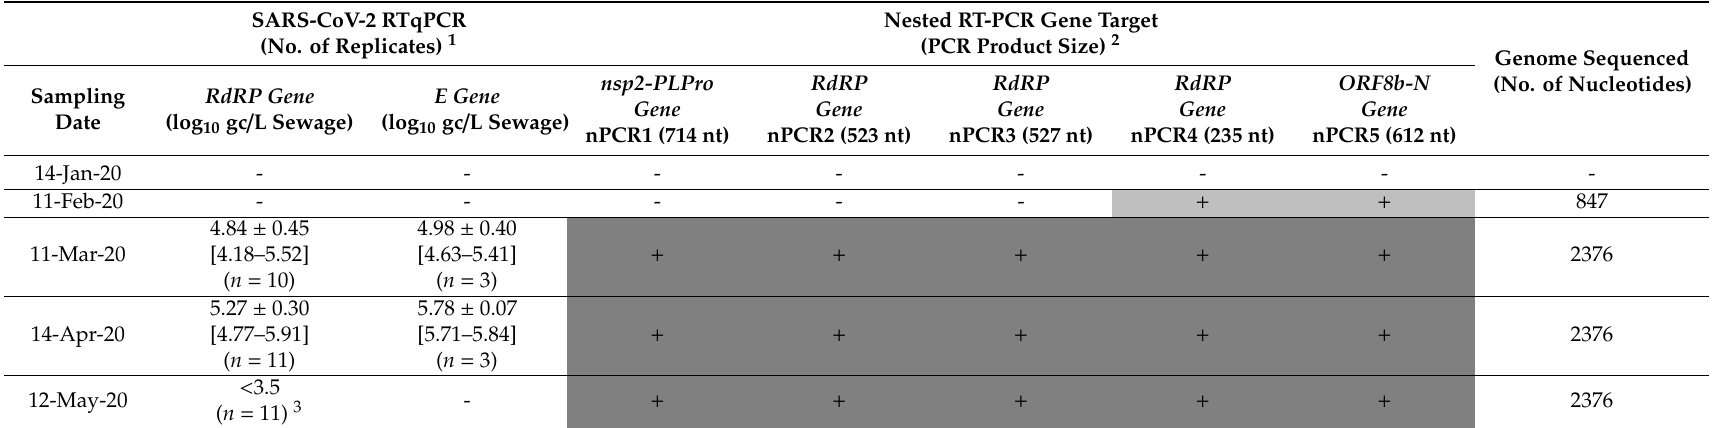
Table 1. Detection of Severe Acute Respiratory Syndrome Coronavirus 2 (SARS-CoV-2) viral RNA in wastewater concentrates by RTqPCR and